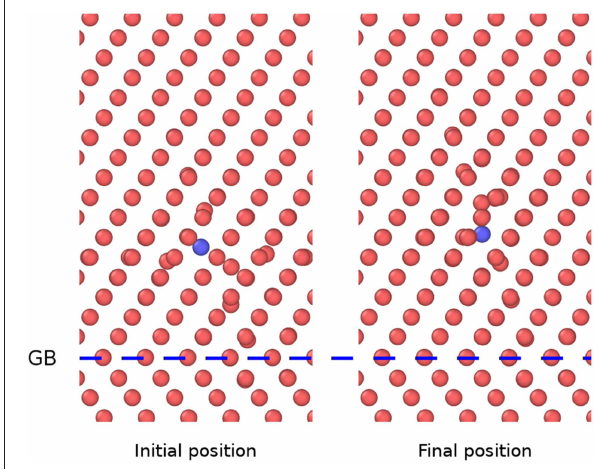
FIGURE 5 | Atomic configuration of Fe-P mixed dumbbell in the model P 3{112}109.5 ◦ , showing initial and final states before and after diffusion away from the GB (The blue spheres denote P atoms and the red ones denote Fe atoms).